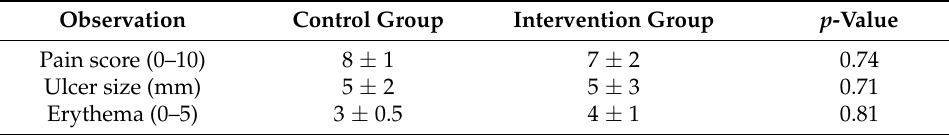
Table 3. Clinical assessment of human volunteer’s average at baseline of treatment.